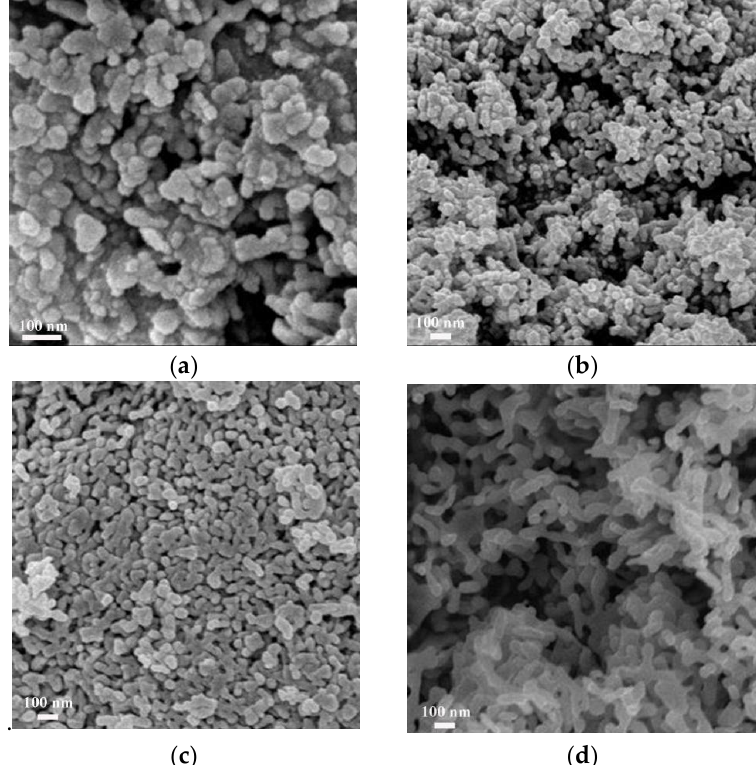
Figure 2. Scanning electron microscopy (SEM) images of α-Fe 2 O 3 reacting for ( a ) 4 h, ( b ) 6 h, ( c ) 10 h and ( d ) 12 h at 180 °C.